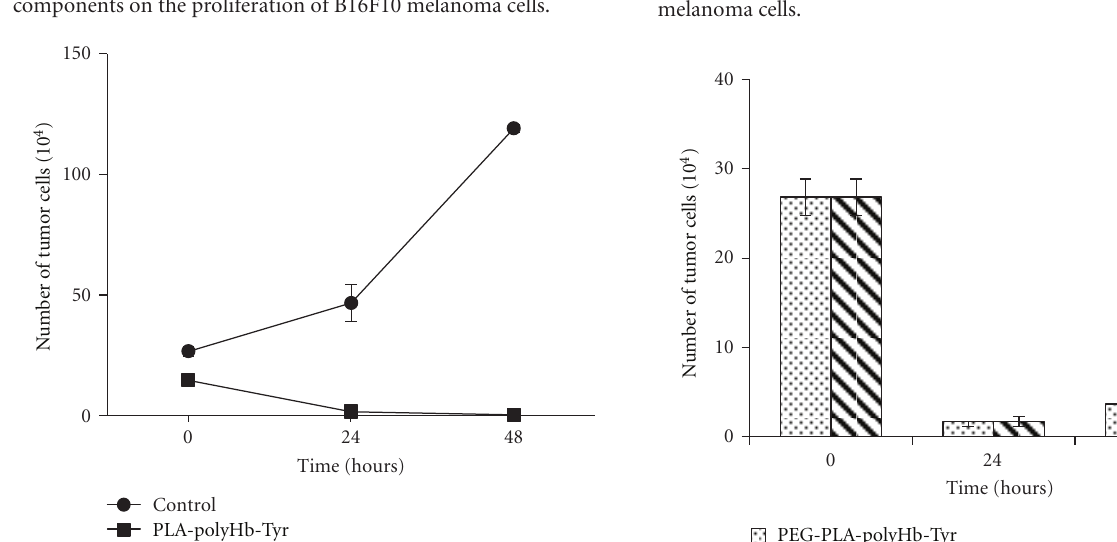
Figure 7: PLA nanocapsule [polyHb-Tyr] and the e ff ects of its components on the proliferation of B16F10 melanoma cells.